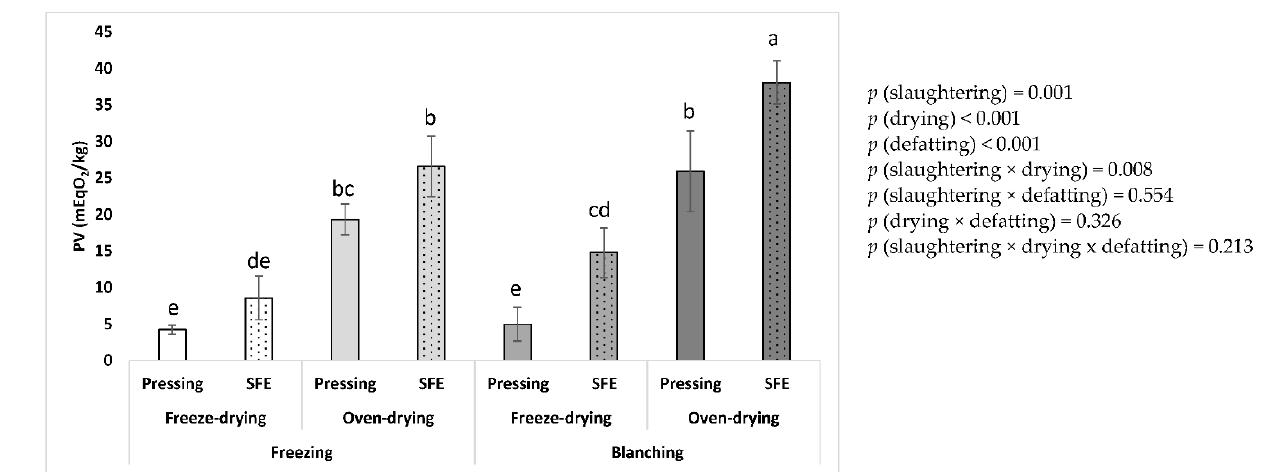
Figure 6. Initial oxidative state (PV) of the defatted meals from BSFL processed by different methods of slaughtering, drying, and defatting. Different letters between the treatments mean significant differences. Each data point corresponds to mean values ± SD, n = 4.